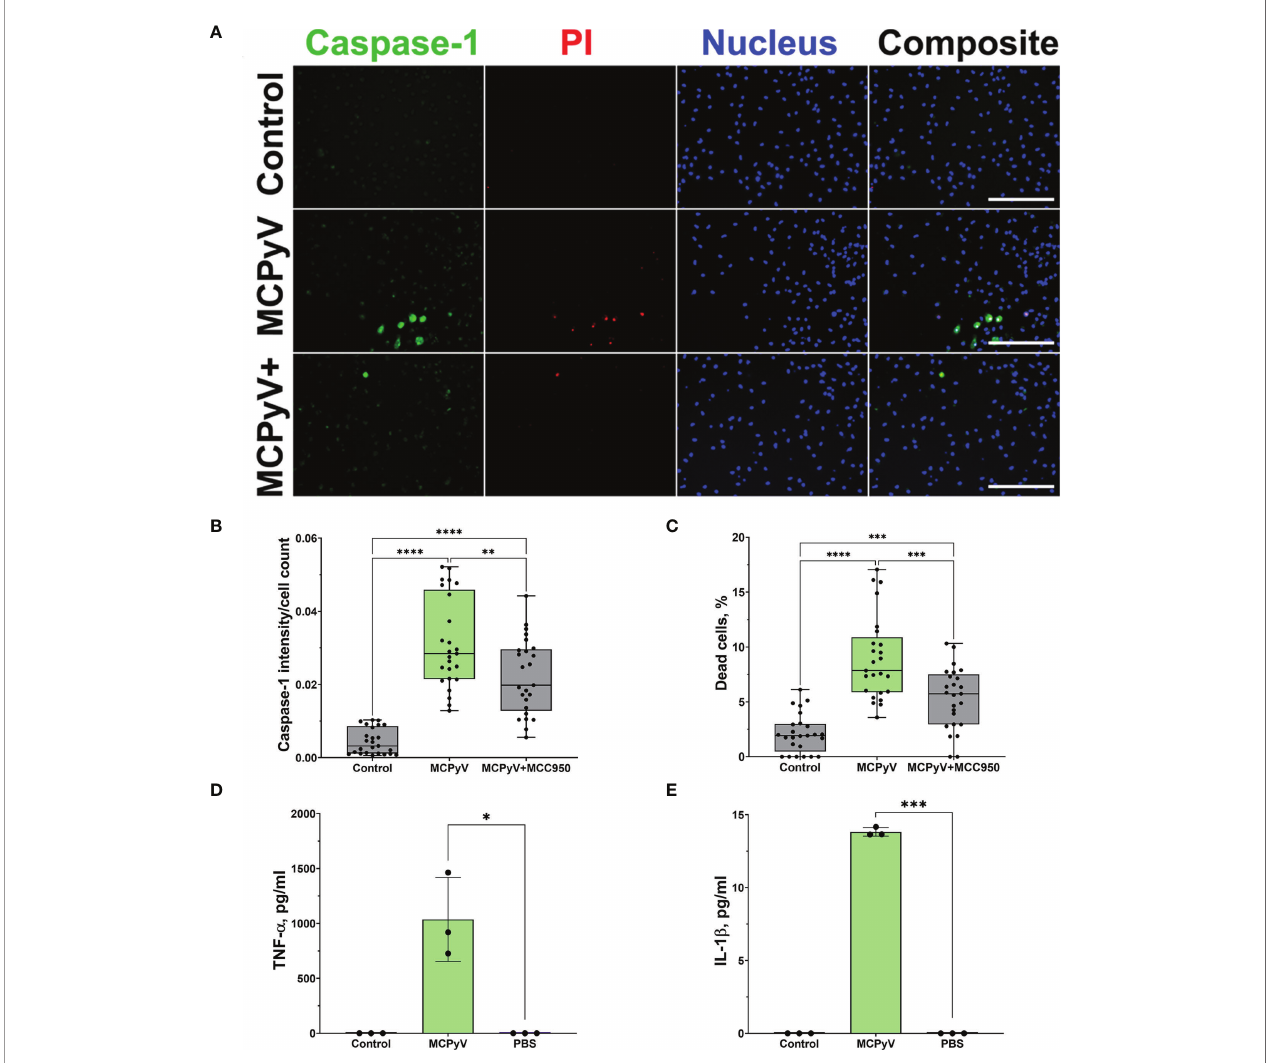
FIGURE 7 | PyV-derived VLPs activated NLRP3 in fl ammasome in primary human macrophages-derived from peripheral blood mononuclear cells. Macrophages were treated for 15 h with PyV-derived VLPs (20 µg/ml); inhibitor MCC950 (1 m M) was added 30 min before treatment. (A) Cells were stained for activated caspase- 1 using FLICA (green), dead cell nuclear stain PI (red), and nuclear stain Hoechst (blue). The images were taken using 20× objective. Representative images of the staining are shown. The scale bars indicate 100 m m. (B) Quanti fi cation of dead cells, n = 25 photos per condition. (C) Caspase-1 quanti fi cation according to FLICA analysis, n = 25 photos per condition. After 24 h treatment with PyV-derived VLPs, collected supernatants were analyzed by ELISA for (D) TNF- a and (E) IL-1 b release, n = 3 technical repeats. For (A – C) , data were analyzed using one-way ANOVA followed by Tukey ’ s multiple comparison test and represented using box plots with dots showing individual data points. For (D, E) Student ’ s t -test was used and data were represented using bar graphs (means ± SD) with dots showing individual data points. * p < 0.05, ** p < 0.01, *** p < 0.001, **** p < 0.0001. N =